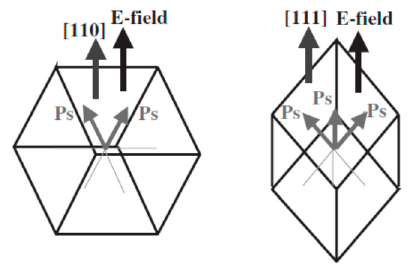
Figure 2. Schematic model of the engineered domain configurations for the tetragonal 4mm ferroelectric crystals (Ps: spontaneous polar vector along the <001> c directions) [33].